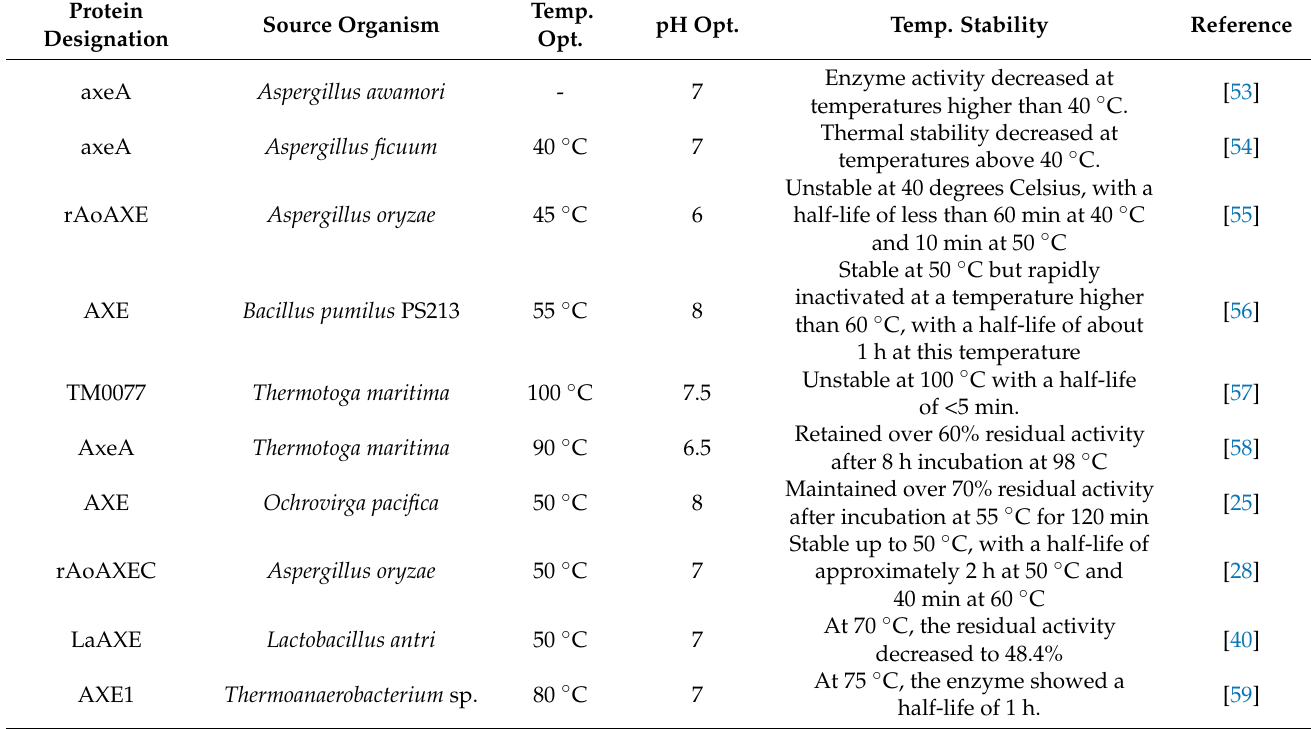
Table 2. Characteristics of acetyl xylan